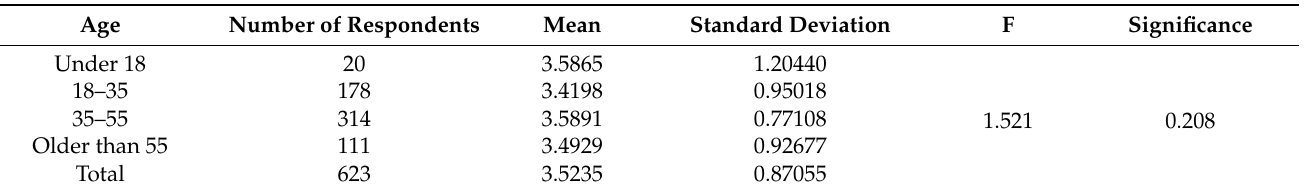
Table 14. Results of the test for differences in waste-sorting behavior between respondents of different ages.